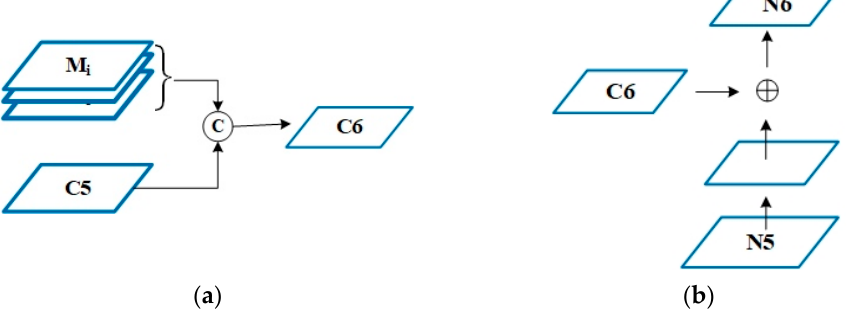
Figure 3. Illustration of feature layer fusion: ( a ) C6; ( b ) N6.